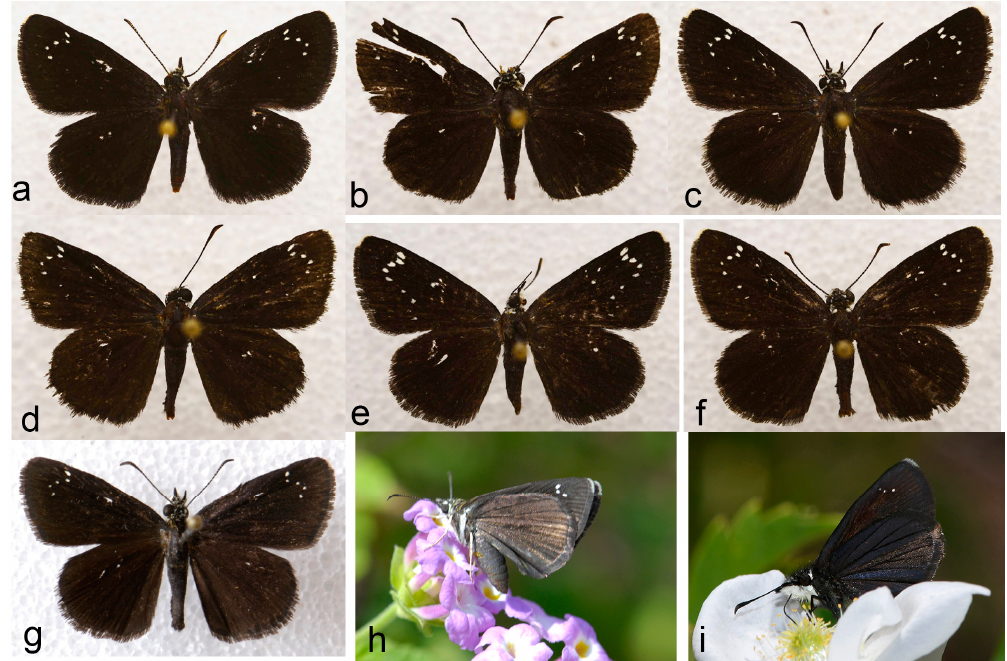
Figure 1. Photographs of Pholisora catullus samples from Sonora, Mexico used for barcoding (dorsal surface). Wingspans are given in mm. ( a ) CIAD 14–EP12, ♂ , 27 mm; ( b ) CIAD 14–EP14, ♂ , 24 mm; ( c ) CIAD 14–EP15, ♀ , 27 mm; ( d ) CIAD 14–EP16, ♂ , 23 mm; ( e ) CIAD 14–EP17, ♀ , 26 mm; ( f ) CIAD 14–EP18, ♂ , 24 mm; ( g ) CIAD 16–EP69, ♂ , 27 mm. See Table 1 for collection data. All specimens are from COI haplotype group 1, except ( c ) CIAD 14–EP15 (haplotype group 3). The ventral surface of live adults (not barcoded) of P. catullus from Sonora, Mexico ( h ) and P. mejicanus from Torrance Co., New Mexico, USA ( i ); photo courtesy of Ken Kertell, shown to illustrate the diagnostic black veins on the hindwings of P. mejicanus .